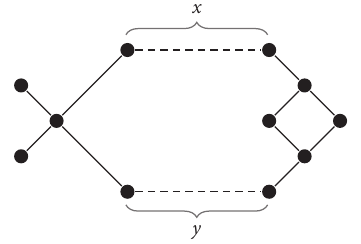
Figure 9: The bicyclic graph G